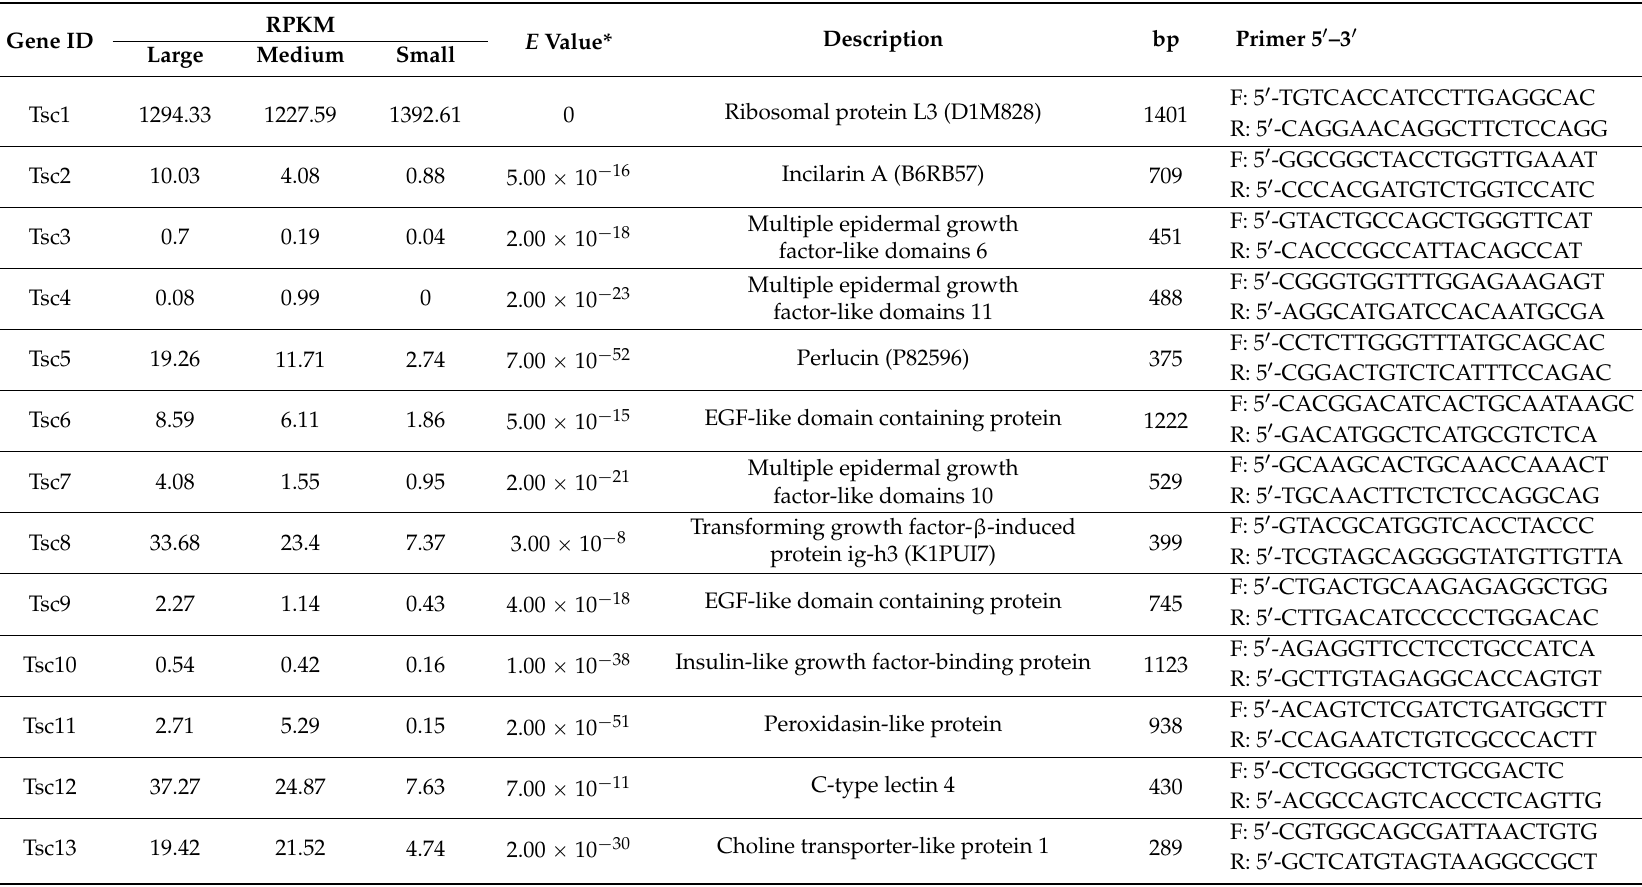
Table 3. Genes tested for differential expression by Reverse Transcription-PCR (RT-PCR). Transcript levels identified by RNAseq analysis of large, medium, and small size abalones were shown for RPKM values. The Tsc1 housekeeping gene, which encodes ribosomal protein L3, was included as a control. Nucleotide sequences of primers used for RT-PCR were indicated. E value refers to the number of random hits one can expect by chance for the query sequence upon